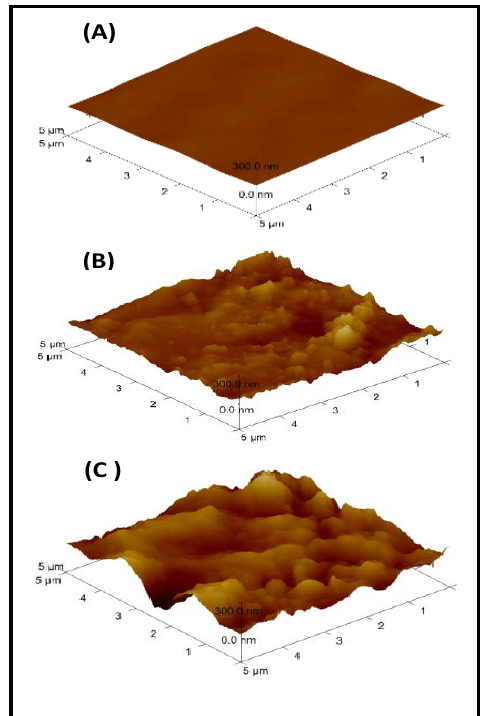
Figure 4. Atomic force microscopy (AFM) Images: CNT pristine ( A ), Ar-CNT-P ( B ) and Ar-CNT-C ( C ) composites with 7.5 wt % of CNTs.